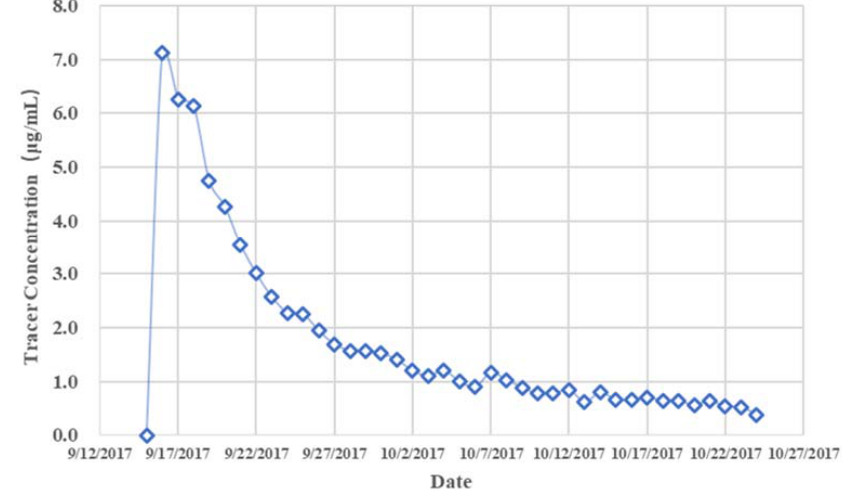
Figure 4. The concentration of the tracer 1,5 ‐ naphthalene disulfonate detected from QJ ‐ 15 and it was injected from QJ ‐ 14 well.